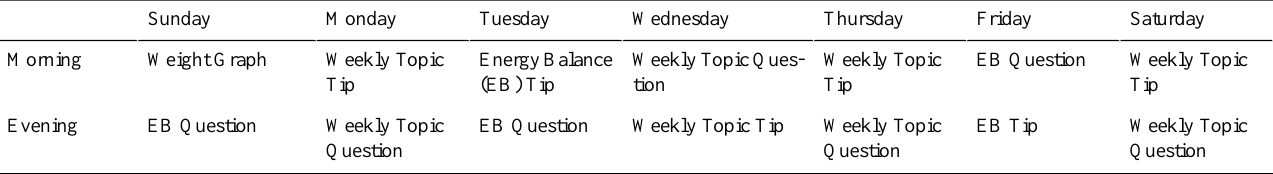
Table 1. Representative weekly sequencing of SMS and MMS